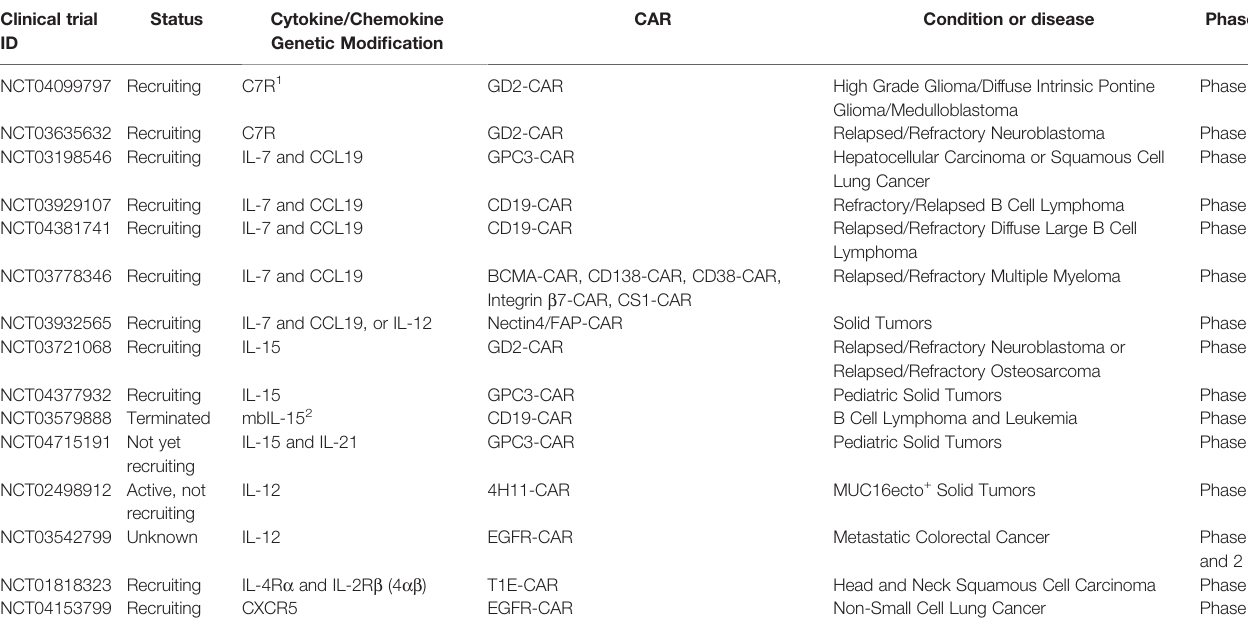
TABLE 2 | Selected clinical trials with cytokine/chemokine genetically-modi fi ed CAR T cells. Clinical trial